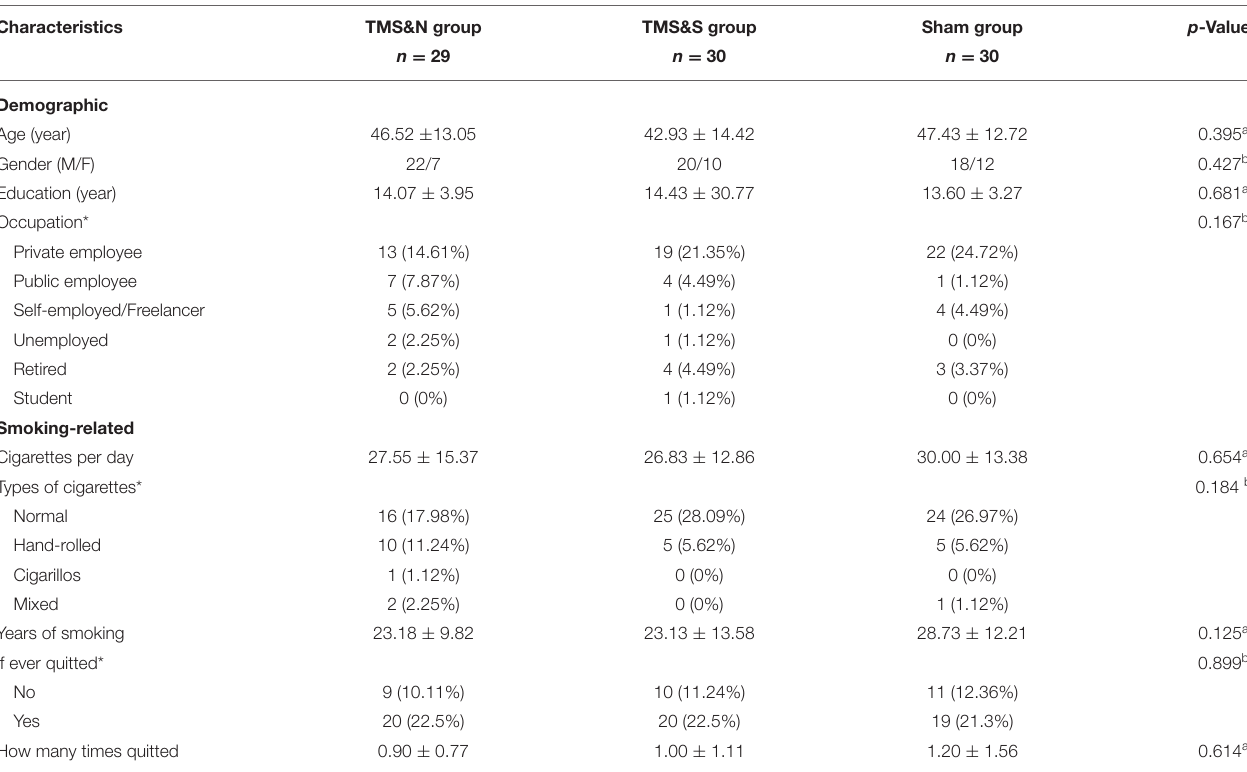
TABLE 1 | Demographic and smoking-related characteristics of ( N = 89) participants.